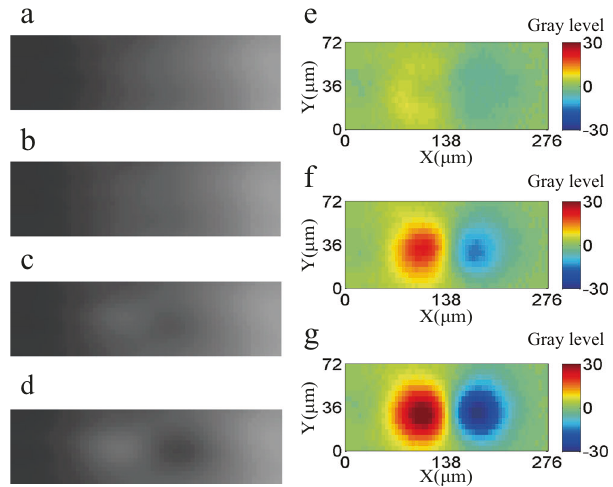
Fig. 4 Local fl ux changing with loading time of the sample strained under zero- fi eld-cooled conditions at 64 mT and 40 K. a – d The magnifying images of the local area at 0, 20, 25, and 30 ms, respectively. e – g The grey level differences between each moment and the reference at the moment of 0